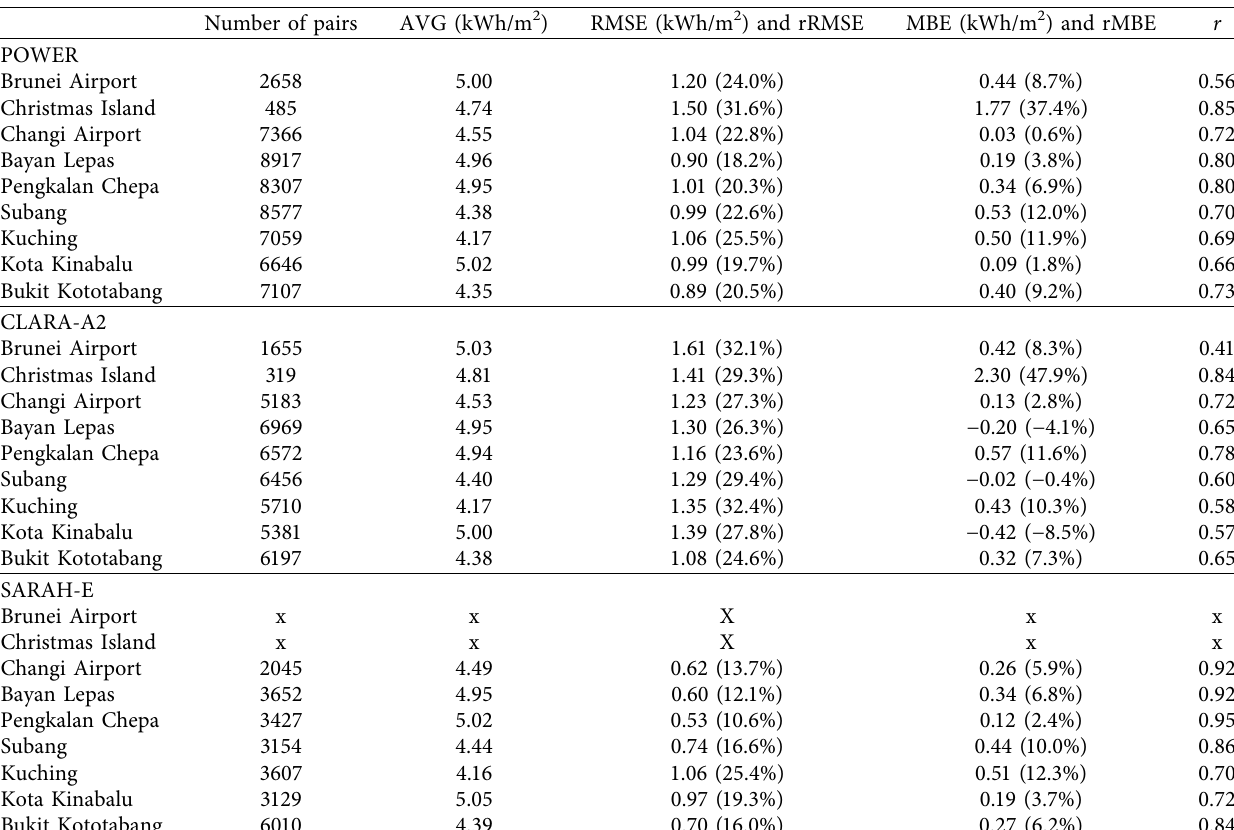
Table 3: Daily energy resource validation result of POWER, CLARA-A2, and SARAH-E against data retrieved from WRDC network